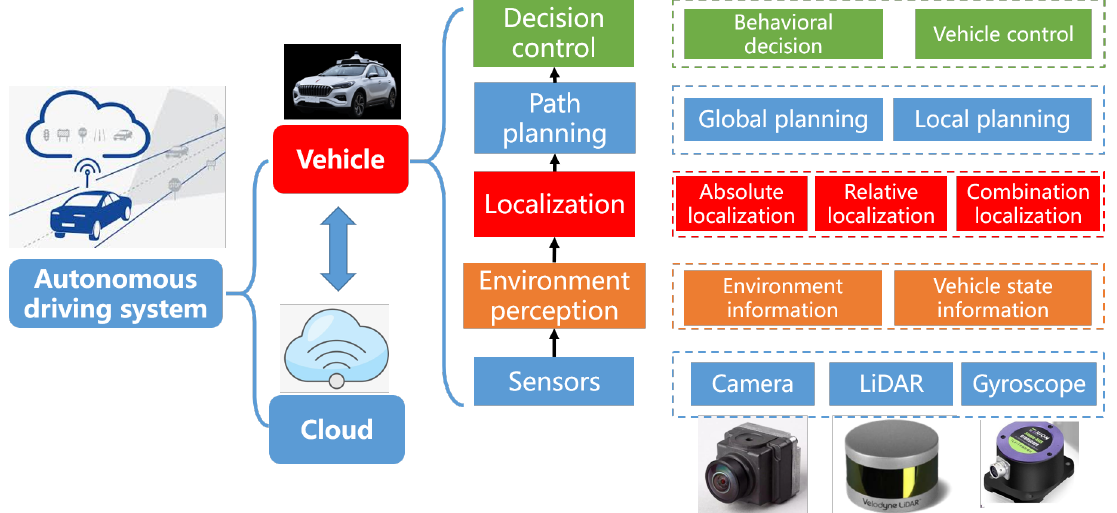
Figure 1. Illustration of autonomous driving system.